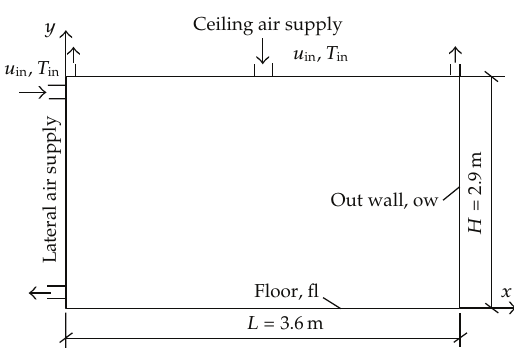
Figure 1: Schematic of radiant heating system and coordinate